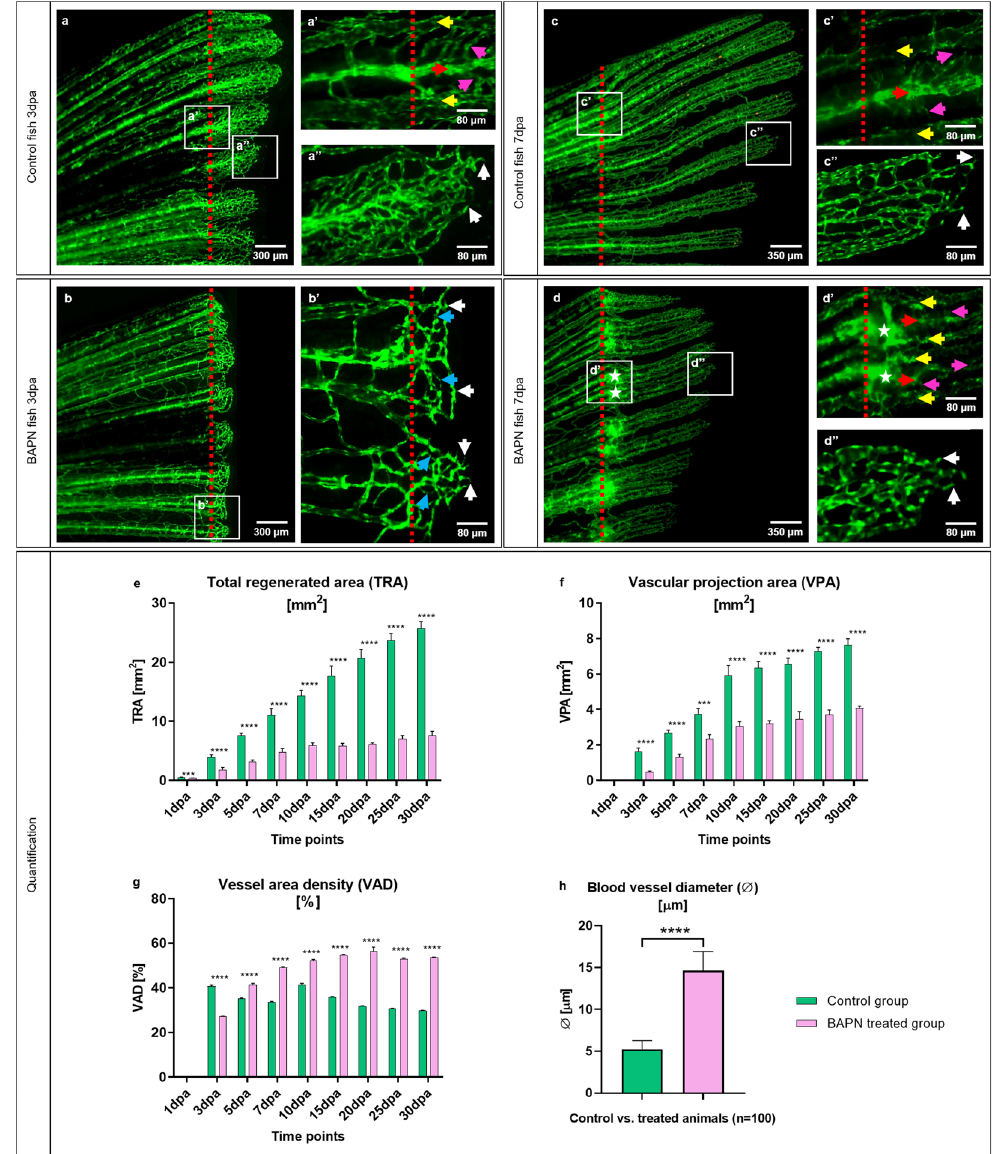
Figure 3. In vivo effects of the collagen cross-linking inhibitor, BAPN, on caudal fin regeneration and neoangiogenesis. Vascular alteration during normal fin regeneration ( a , c ) versus BAPN-treated group ( b , d ) at 3dpa and 7dpa is documented (green - reporter transgenic zebrafish line). Vessels in the regenerating region of the controls ( a, a’ and c, c’ , red dotted lines indicate the amputation) appear hierarchically well organized, building a vascular tree with arteries (red arrow), veins (yellow arrows) and connecting capillaries (purple arrows). Capillaries at the vascular front are representing multiple sprouts ( a’’ , c’’ , white arrows). Shorter regeneration area and respectively modest vascularization in BAPN-treated animals ( b ); hierarchical organization in supplying and draining vessels as well as capillaries is less pronounced. Many capillary connections are very thin and not perfused ( b’ , blue arrows); multiple sprouts are visible at the vascular front ( b’ , white arrows). At 7dpa the regenerating region, respectively the vascular plexus is smaller in comparison to the controls. Balloon-like enlarged blood vessels (detectible as a green sphere) are visible at the site of amputation ( d , d’ , asterisks). Those angioma-like structures are connected to the arteries ( d’ , red arrow) and in some cases to the veins ( d’ , yellow arrows). Further distal tiny connecting capillaries are indicated by purple arrows ( d’ ): vessel network is disorganized and contains higher number of ECs as indicated by the dense nuclear appearance. Images are acquired with a fluorescent reflected light microscope. Quantification of tissue regeneration and vascularization after inhibition was assessed by three variables: Total regenerated area (TRA = regenerated fin in mm2; e ), vascular projection area (VPA = vessels within regenerated part in mm2; f ) and vessel area density (VAD = vessels density within the regenerated part in %; g) during a period of 30 days in control group (green) versus BAPN-treated group (purple). n = 5. h ) Quantification of lumen dimensions (in μm) between control and BAPN-treated animals. Blood vessel diameter in BAPN-treated animals increases by 70%; n =